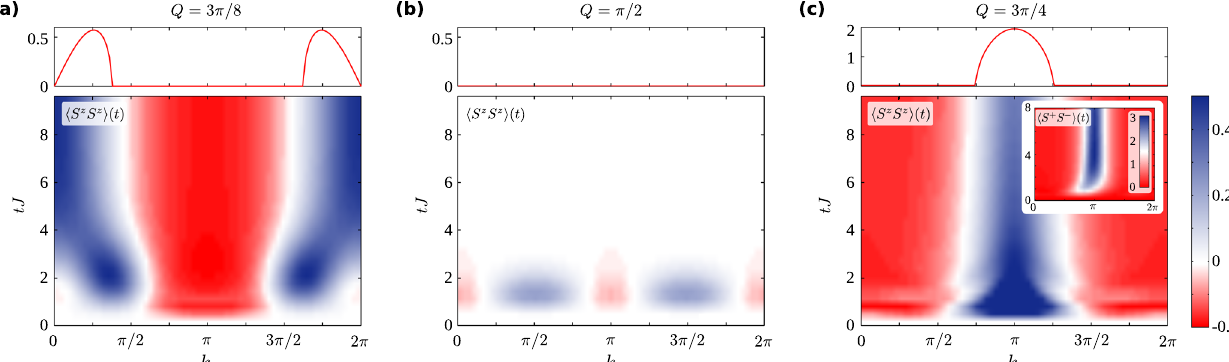
FIG. 4. The evolution of spin correlations. Top panels: Growth rate of out-of-plane instable modes obtained from a linear response analysis. Bottom panels: Numerically calculated correlation function h k ¼ ð k; k; k Þ within the spin-2PI formalism including NLO corrections. (a) Q ¼ 3 π = 8 , (b) Q ¼ π = 2 , and (c) Q ¼ 3 π = 4 . The inset in (c) shows the connected part of the in-plane correlations h